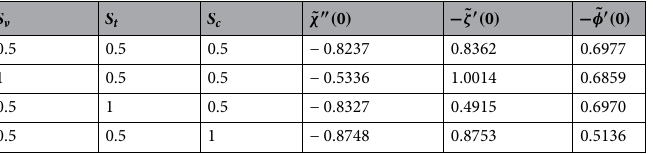
Table 5. For A = 0.5 and different values of S v , S t , S c with M = 3, Gr = 2, Pr = 7, Gc = 2, Ec = 0.5, and Sc = 0.6 the values of ˜ χ ′′ ( 0 ) , −˜ ζ ′ ( 0 ) , − ˜ φ ′ ( 0 )